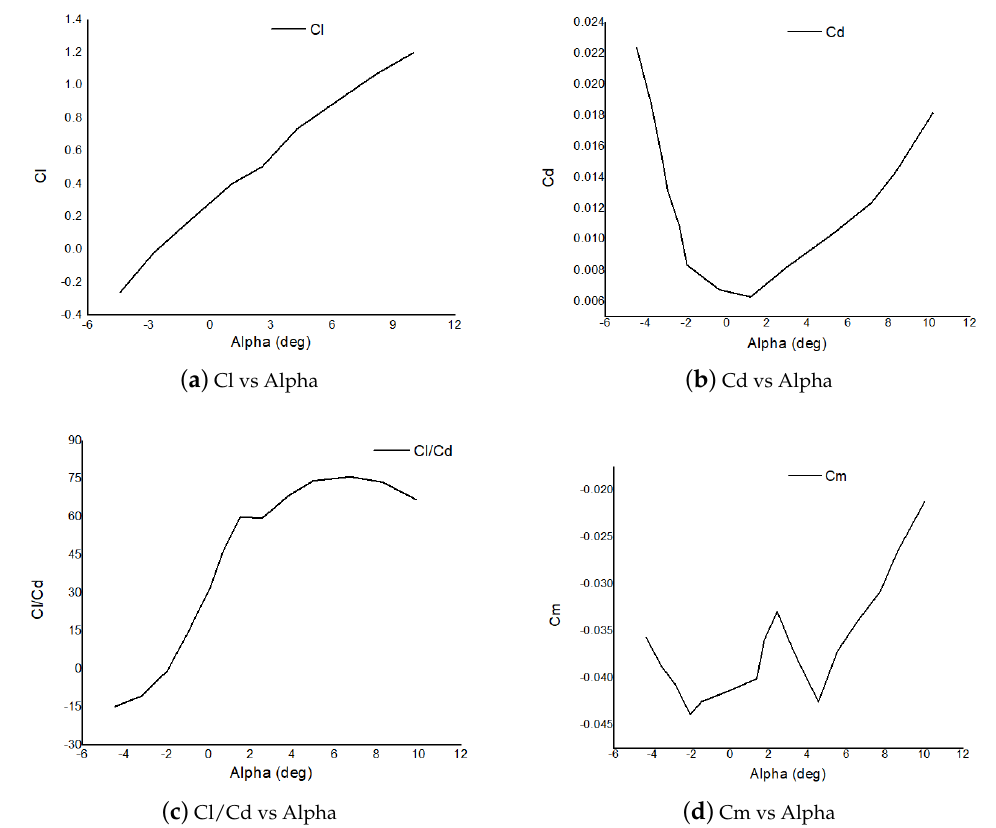
Figure 11. Airfoil analysis; Variations of lift, drag, and moment coefficients with angle of attack obtained using